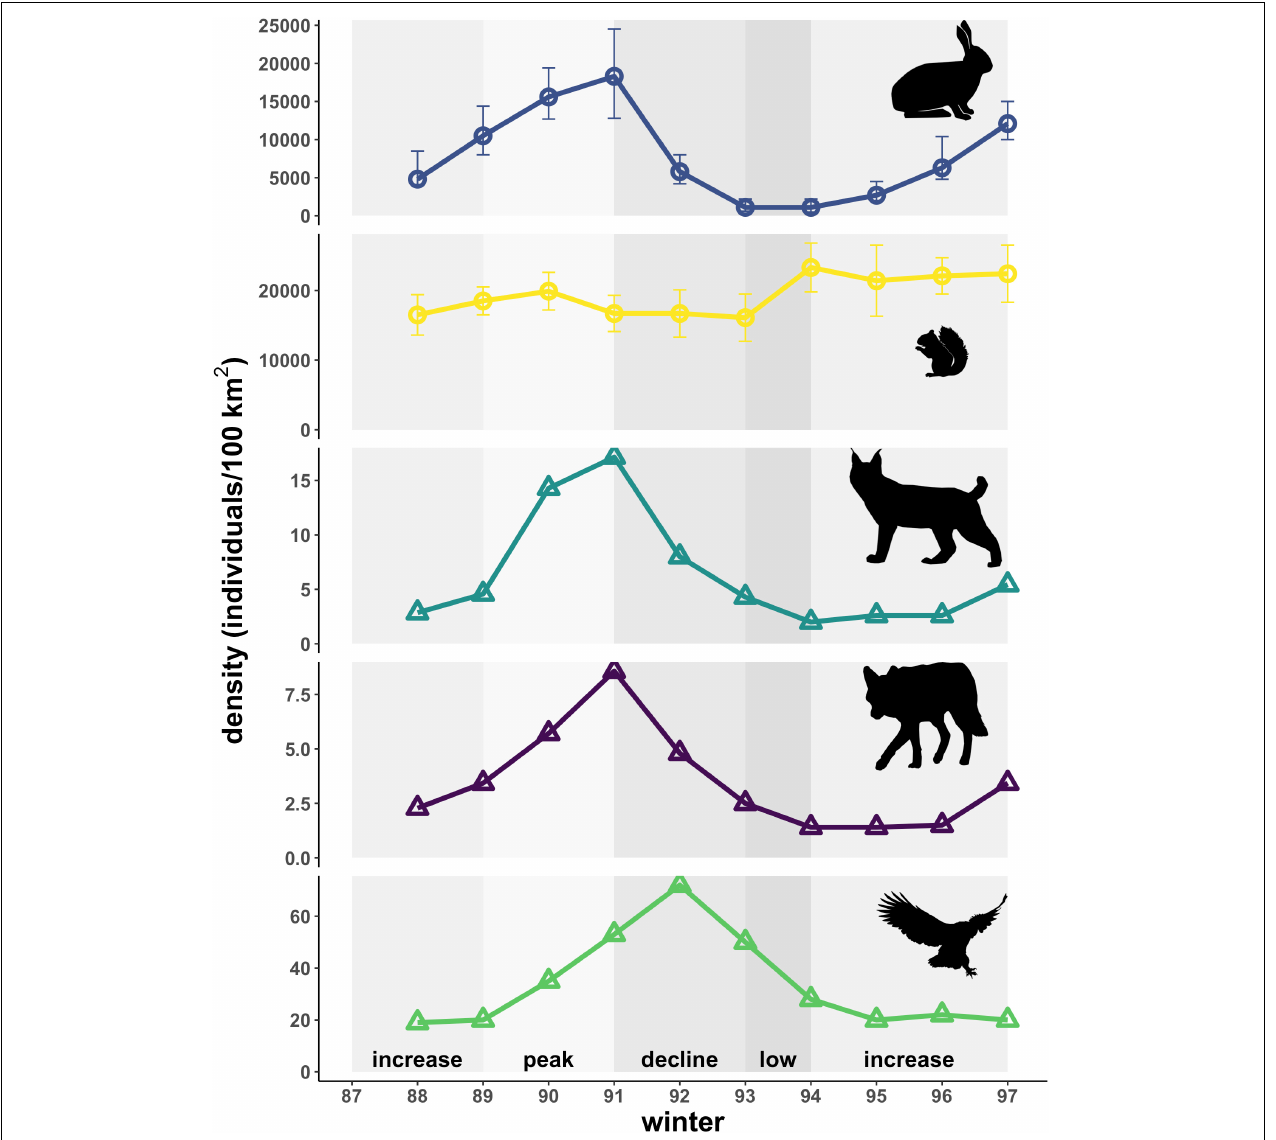
FIGURE 3 | Estimated densities of predators (triangles) and prey (circles) for the simplified Kluane food web in winter. Densities of key predators (lynx, coyotes, owls) follow that of hares. Red squirrels, whose densities are independent of hares, serve as an alternate prey for lynx and coyotes. Shading indicates phases of the cycle as defined by hare density. Error bars for prey species represent 95% confidence intervals. Predator species lack confidence intervals, as densities shown here represent absolute counts from within the study area. Also note varying y-axis scale for each